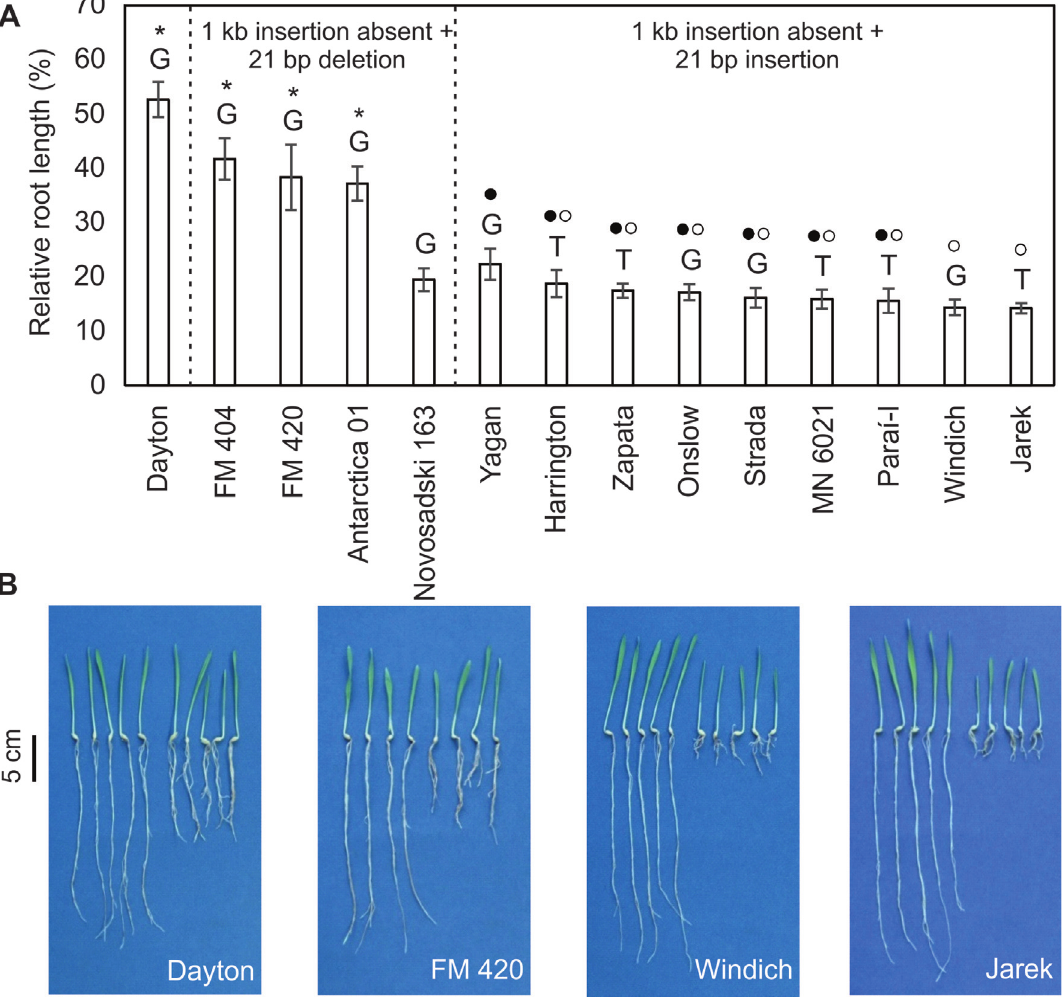
Figure 4 - Relative root length (RRL) of 14 barley genotypes belonging to different haplotypes in a short-term soil experiment. (A) Relative root length expressed as a percentage. The columns represent the mean RRL (cid:5) SE RRL . Dayton was the only genotype to contain the 1 kb insertion upstream from the HvAACT1 gene along with the 21 bp deletion of the HvMATE-21indel marker. Letters above each bar represent the SNP (T/G) at position 1,198 of the HvAACT1 coding region. Asterisks indicate the RRLs that were significantly different (p < 0.05) from genotypes without the 1 kb insertion but contain-